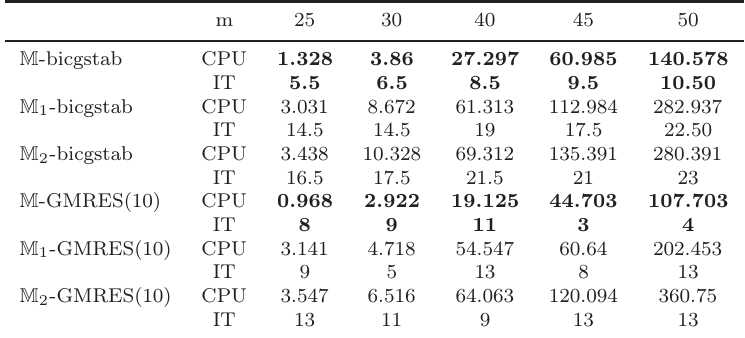
Table 1. Solution time in seconds and number of iterations of GMRES and BiCGSTAB iteration methods with preconditioner M presented in this paper and preconditioners M 1 , M 2 proposed in [19] for µ = 10 , α = 0 . 5 and β = 2 . 2 .